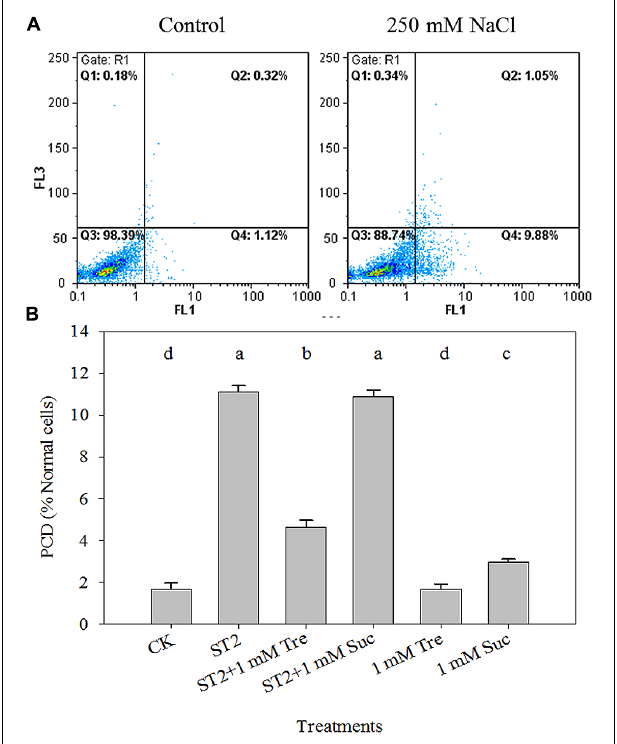
FIGURE 5 |The leaf PCD dynamics occurring in the protoplasts isolated from plants under control or high salinity conditions and analyzed by flow cytometry (FCM). (A) The representative FCM diagrams of PCD levels; (B) The quantitative results of PCD levels.The protoplasts were stained with AnnexinV (FL1 channel) and PI (FL2 channel), and analyzed by FCM.The results showed are the mean ± SE of three replicates and the different letters denote the significant difference among different treatments ( P < 0.05). ST2, 250 mM NaCl;Tre, trehalose; Suc,